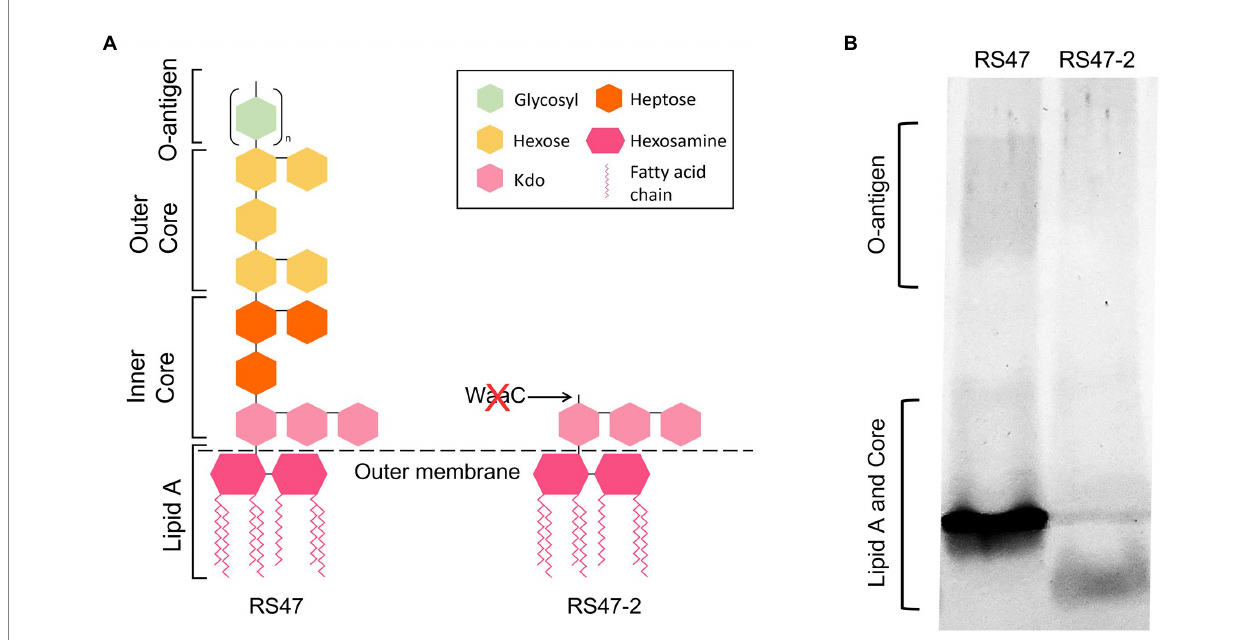
FIGURE 1 Impact of RS47-2 waaC disruption on lipopolysaccharide (LPS) structure. The effects of waaC disruption on LPS structure were assessed by comparison of RS47 WT and RS47-2 LPS profiles. (A) Illustration showing predicted impact of waaC inactivation on LPS structure in RS47-2. (B) Separation of LPS lysates on tris-glycine gels comparing core and O-antigen regions between RS47 WT and